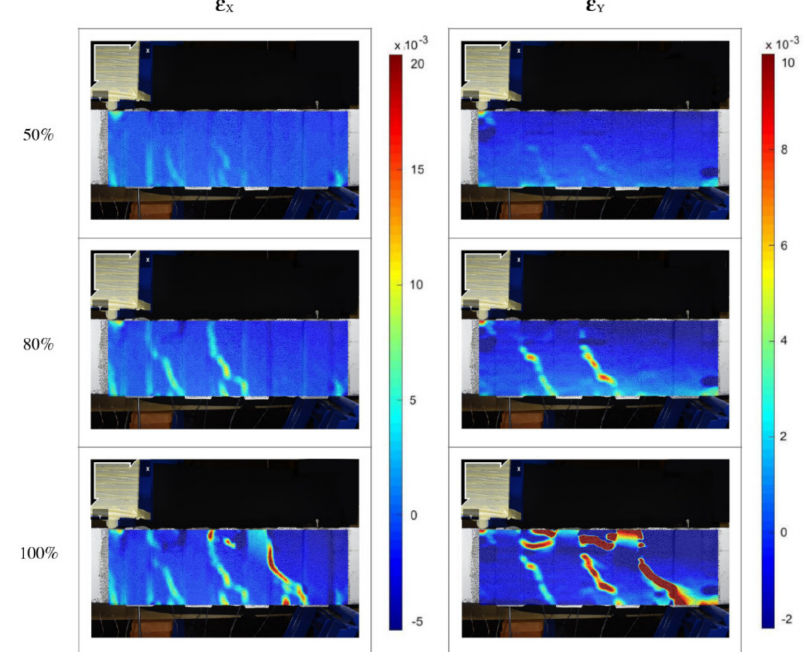
Figure 10. B-D-2L-4S: Strain evolution obtained by using DIC technique.